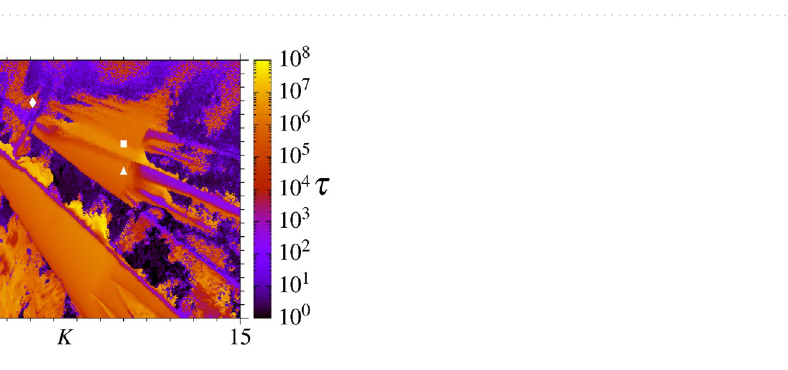
Figure 4. RC’s lifetime τ as a function of N for ( a ) β = 10 − 6 and ( b ) β = 10 − 4 . The black lines are power-law functions τ( N ) ≈ α N χ that adjust the brown curves obtained through the average computed over all studied cases (excluding the case of ( K , γ) = ( 6.1, 0.80 ) in ( b ) ). ( c ) The RC’s lifetime is plotted as a function of β for N = 128 . The black line decays with τ(β) ≈ νβ − µ , function which adjusts the brown average curve.